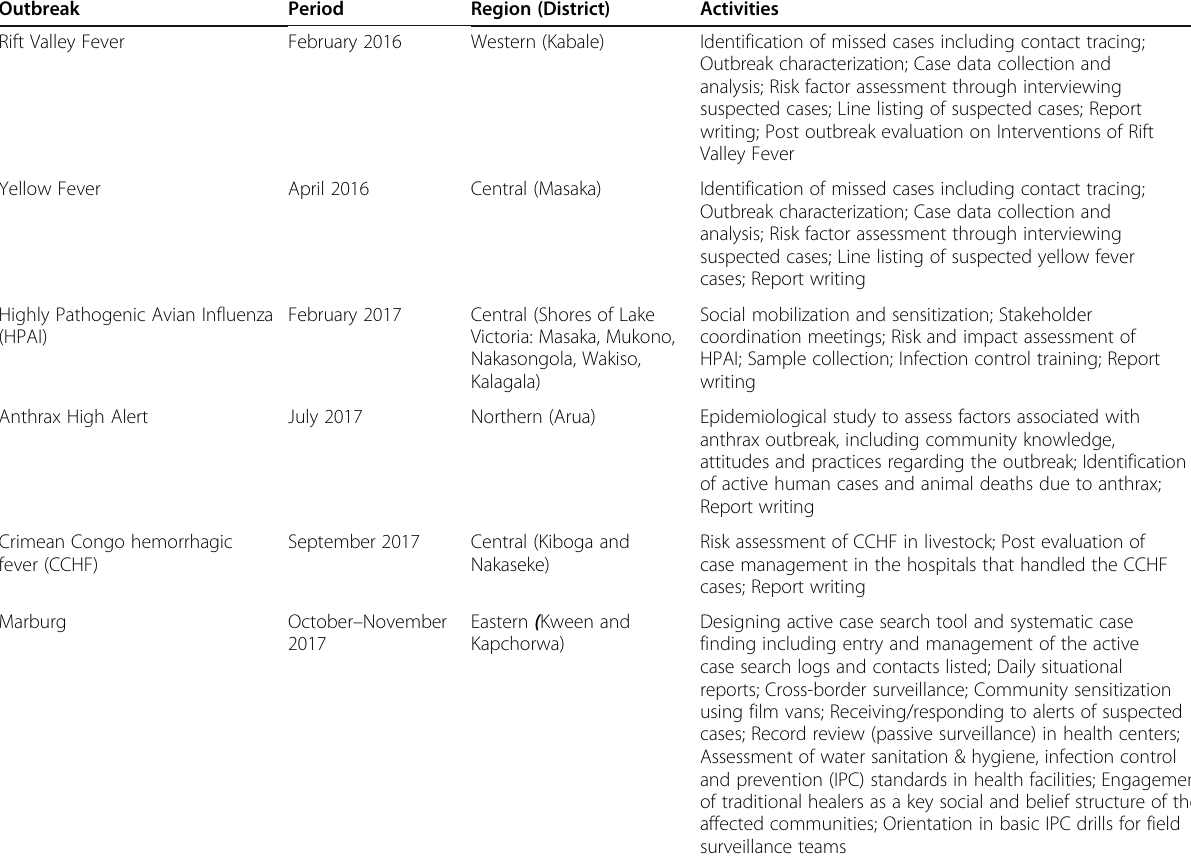
Table 1 Summary of outbreaks in Uganda in which Students One Health Innovation Club members have been